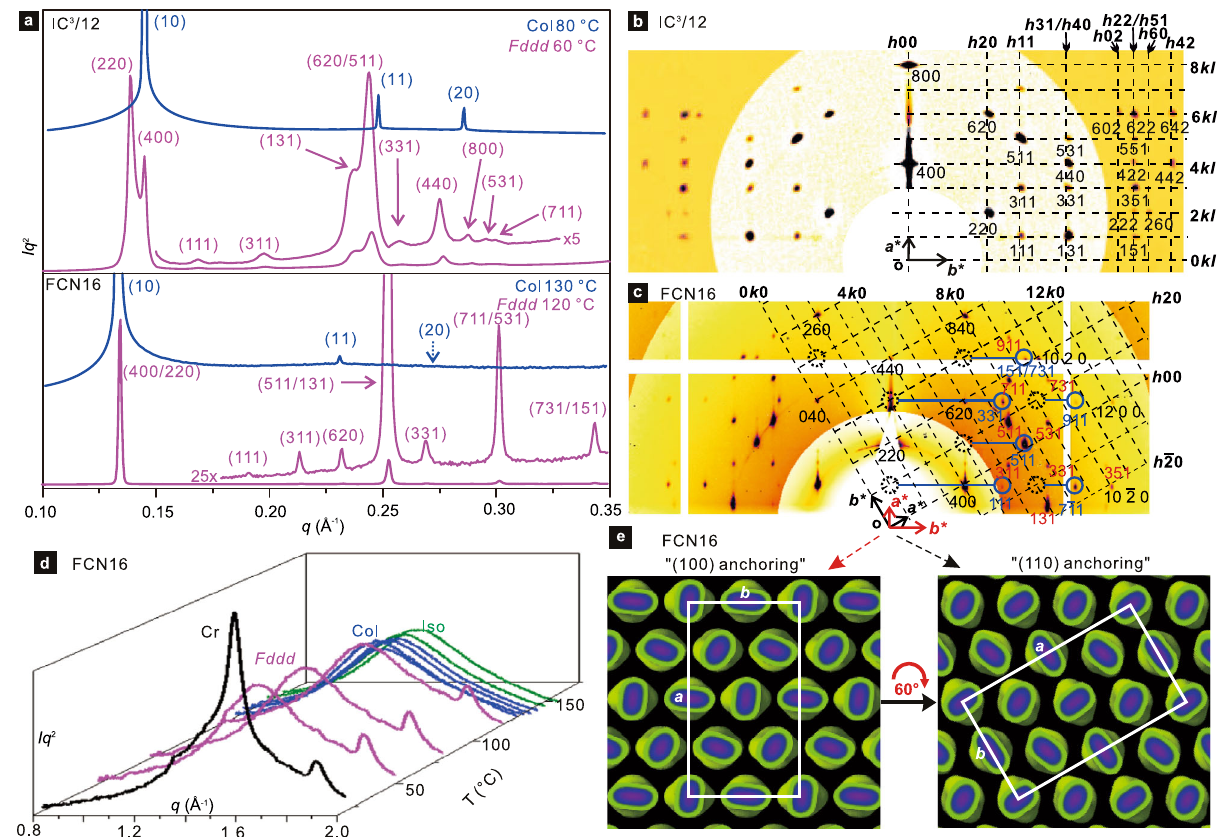
Fig. 3 X-ray diffraction results. a Transmission powder SAXS curves of Col and Fddd phases of IC 3 /12 and FCN16. The dominance of (220) and (400) diffraction peaks show that in both compounds the columns pack on a nearly hexagonal lattice. b , c GISAXS patterns of Fddd phase of IC 3 /12 and FCN16. The background was subtracted and the higher -q zone is intensity-enhanced. The partial reciprocal hk 0 lattice plane is superimposed, with some hkl spots in c circled blue and connected to their hk 0 base by blue row lines (for calculation see Supplementary Fig. 9). Re fl ections in c come from two orientations with (110) and (100) planes anchored on Si substrate; re fl ections in red are from the latter. d Evolution of powder WAXS of FCN16 on heating; note the 3.5 Å peak ( q = 1.8 Å − 1 ) in the Fddd and crystal phases. e Real space FCN16: in both orientations the LC faces substrate with a dense plane of columns (unit cell in All columns in (100) rows along b axis co-rotate, either clockwise or anticlockwise, but along {110} diagonals they counter-rotate, alternating between left and right helicity (Fig. 5a – h). xy sections of the model at different z -elevations (Fig. 6a, b and Supplementary Figs. 17 and 18) show that the linear dimers of FO16 and FCN16 succeed in evading clashes at every level (see Supplementary Movie 6), while the co-rotating stars of IC 3 /n unavoidably clash along b at z = 4.5 Å and z = 13.5 Å (see Supplementary Movie 3). Interestingly, while the a/b ratio for FCN16, FO16, and IC 3 /14 is exactly √ 3 (186.9/107.9, 186.0/107.4, 186.8/107.8), meaning that the column axes sit precisely on a hexagonal lattice, for IC 3 /12 the ratio is 1.635, i.e., the unit cell is stretched along the clash direction b (Fig. 6a). The deviation from hexagonal grid also causes separation of (400) and (220) re fl ections (Fig. 3a). Probably the “ padding ” by the C12- chains is insuf fi cient to fully mitigate the clashes. Signi fi cantly, IC 3 /10 does not form Fddd at any temperature (Table 1).